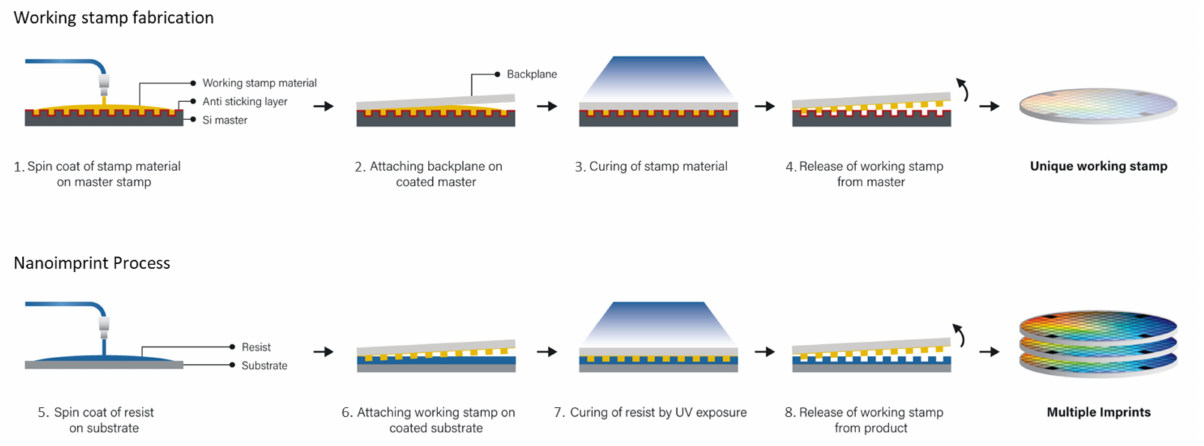
Figure 3. Schematic illustration of the SmartNIL process flow. Steps 1–4 show the typical manufacturing steps for creating a transparent working stamp. Steps 5–8 illustrate the actual imprint process which can be repeated multiple